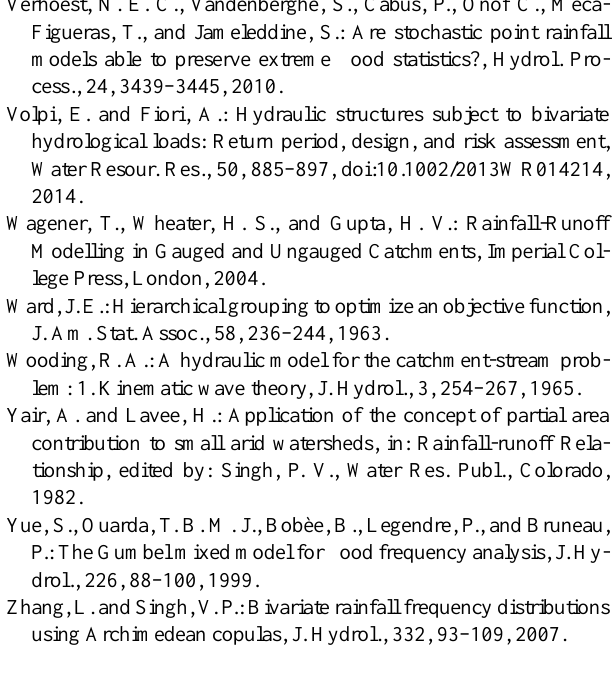
Figueras, T., and Jameleddine, S.: Are stochastic point rainfall models able to preserve extreme flood statistics?, Hydrol.